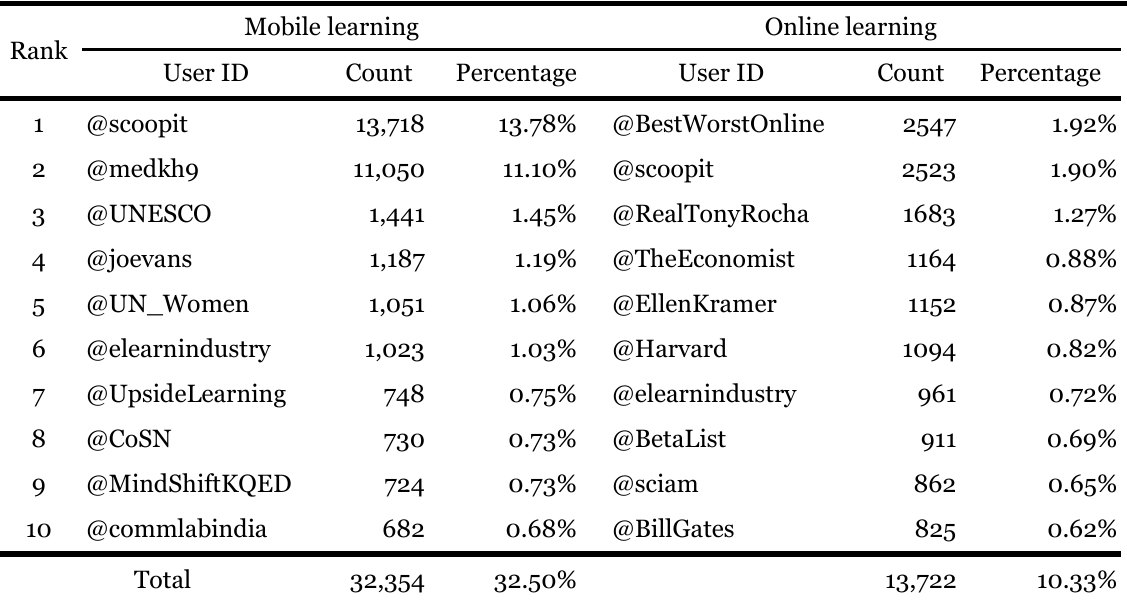
Top 10 Users by the Number of